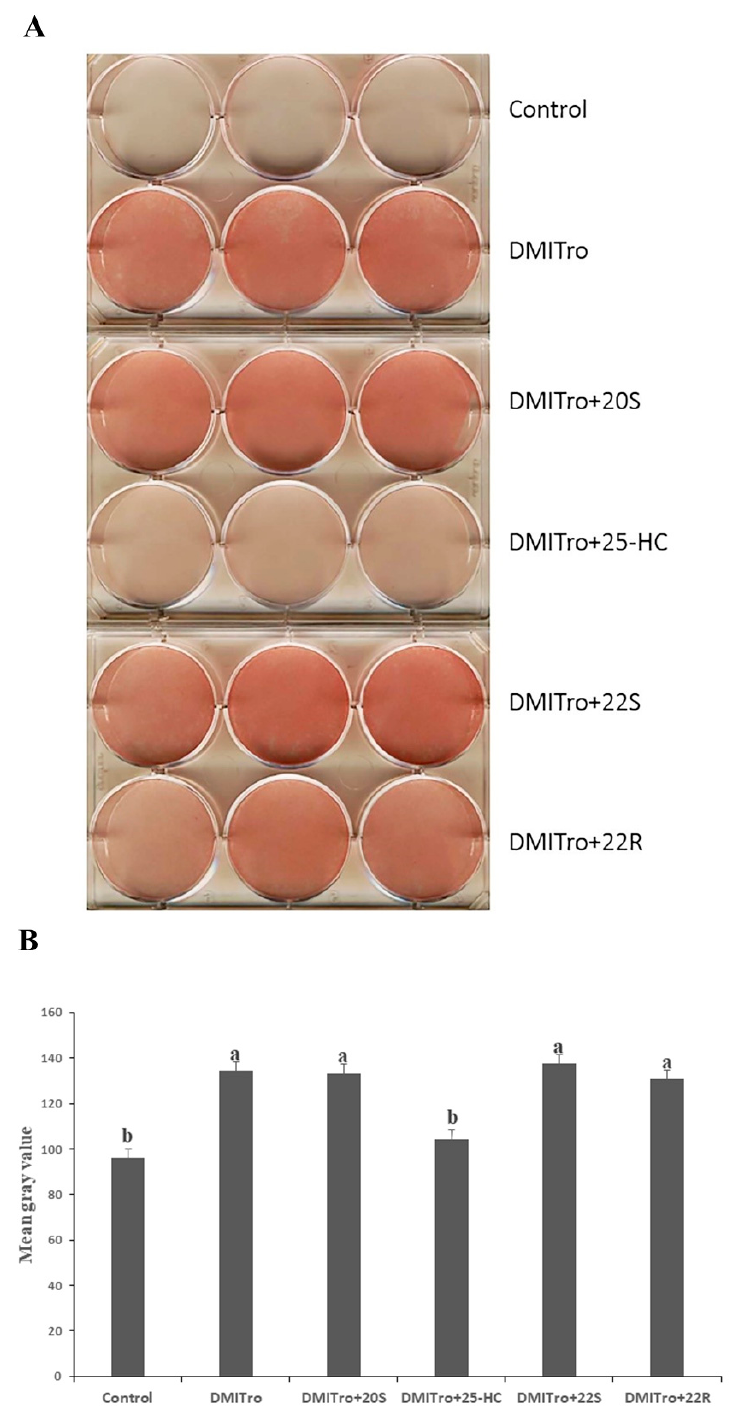
Figure 1. Representative image of C3H10T1 / 2 mouse cells treated with a control, DMITro (500 nM DEX, 0.5 mM IBMX, 20 µ g / mL Insulin and 10 µ M Troglitazone), DMITro + 10 µ M 25-HC, 20S, 22S or 22R hydroxycholesterols for six days, followed by oil red O staining and scanning of plates for lipid accumulation comparisons. ( A ) oil red O stanning results ( B ) The mean gray value (in pixel) of oil red O staining. The results show the average values of three replicates ( n = 3) and the SE of the means. Bars with the di ff erent letters are significantly di ff erent ( p < 0.001).